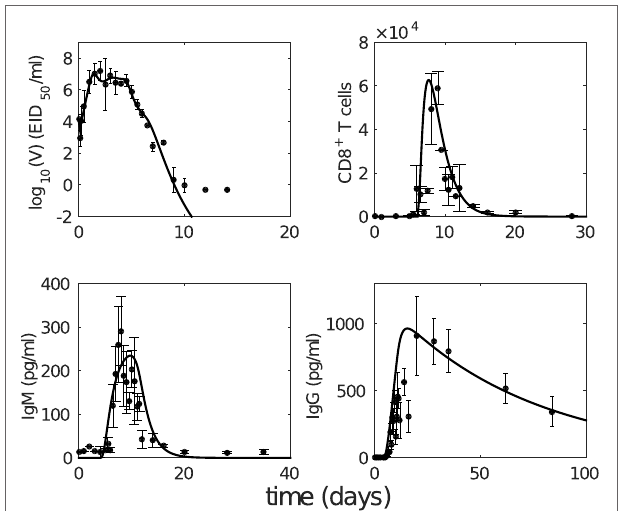
FIGURE 3 | Model solution for non-fitted variables . T , I , and R represent the numbers of target cells, infected cells, and resistant cells, respectively. F represents the level of IFN (a dimensionless variable). C n and B n represent the numbers of naive CD8 + T cells and naive B cells, respectively. P represents the number of antibody-secreting plasma cells. Parameter values used to generate the results are given in Table 1 . Note that model solutions for fitted variables are shown in Figure 2